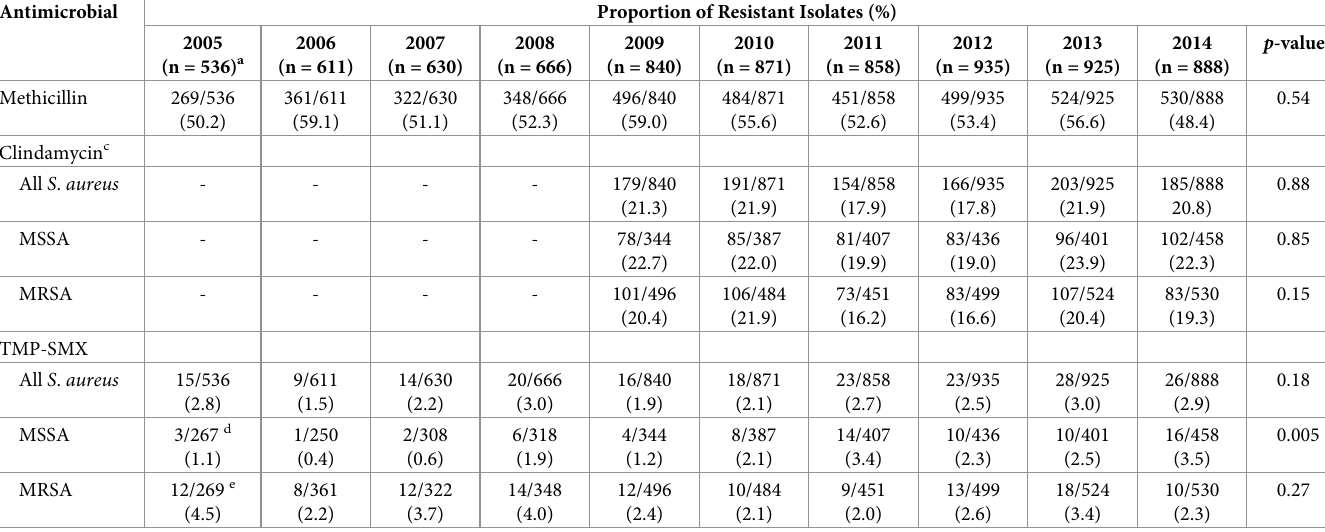
Table 3. Antimicrobial resistance per year among all S . aureus , MSSA, and MRSA inpatient isolates from NCH (2005–2014). Antimicrobial